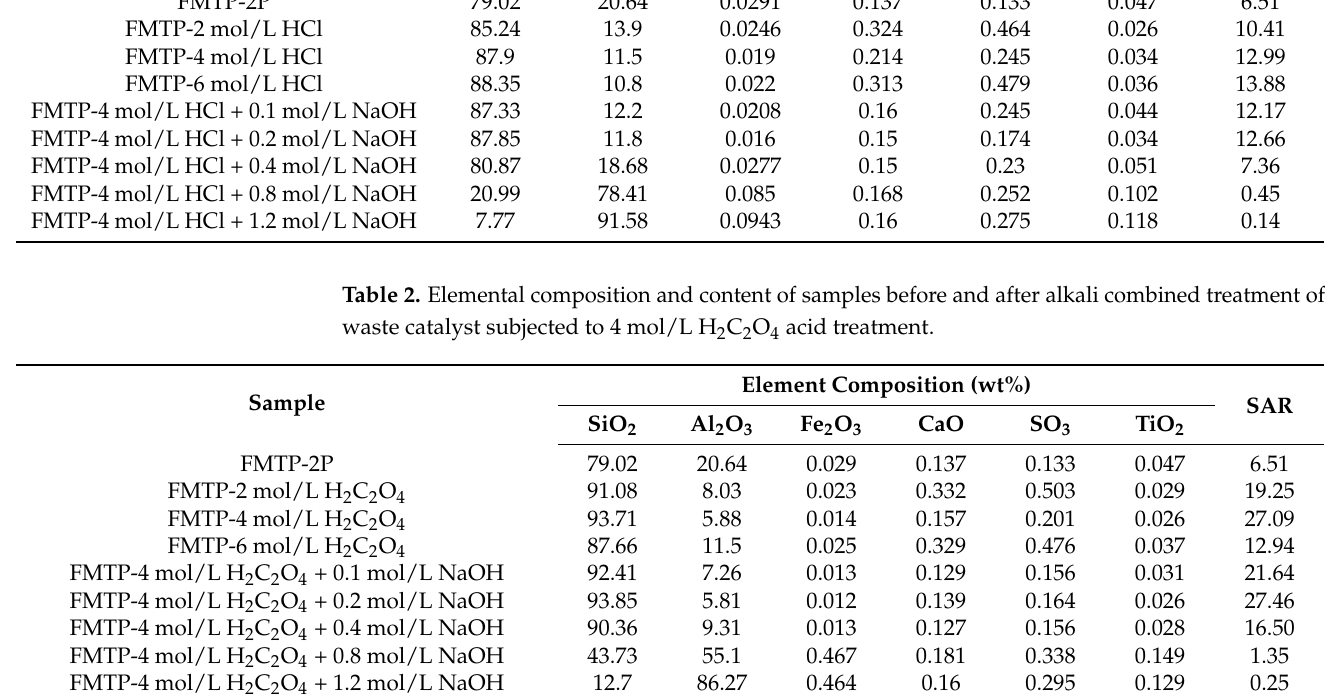
Table 1. Elemental composition and content of waste catalyst samples after 4 mol/L HCl acid and alkali combined treatment. Sample